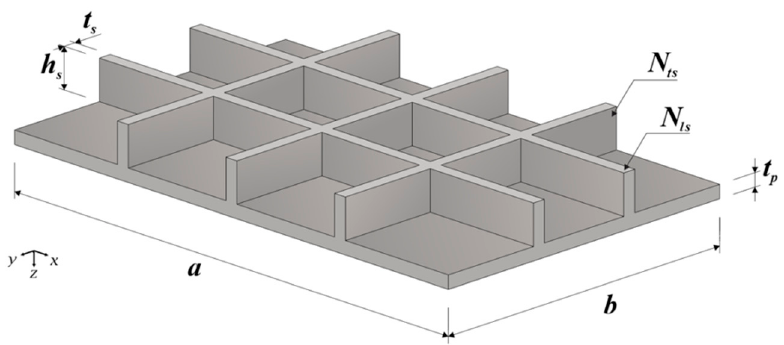
Figure 5. Stiffened plate with two longitudinal and three transverse stiffeners.